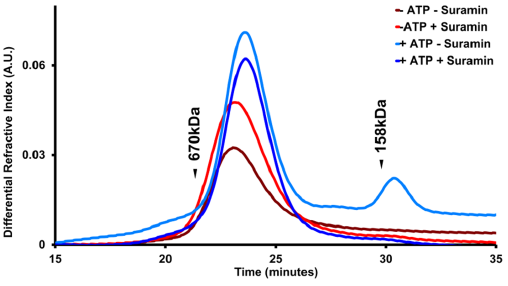
Figure 6. Suramin does not disrupt Hsp104 hexamers. Gel filtration analysis of Hsp104 in the absence and presence of Suramin (100 m M) both in the presence and absence of ATP (1 mM). Protein elution profiles monitored by refractive index are shown for Hsp104 with and without nucleotides and in the absence or presence of Suramin in the sample and running buffer. Elution positions of relevant molecular weight standards are shown.